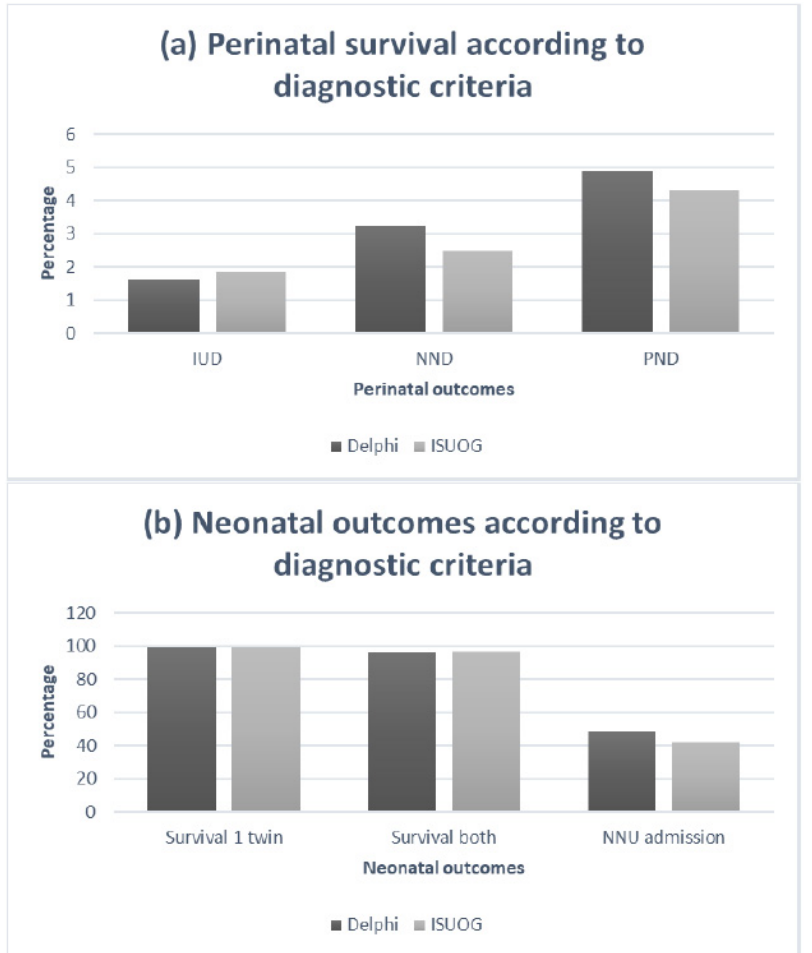
Figure 2. Perinatal and neonatal outcomes of sFGR DCDA twins according to Delphi and ISUOG diagnostic criteria: ( a ) Bar chart demonstrating the incidence of IUD (intrauterine demise), NND (neonatal death), and PND (perinatal death) in the Delphi and ISUOG criteria groups; ( b ) Bar chart demonstrating the incidence of neonatal outcomes (survival of one twin, survival of both twins, and neonatal unit (NNU) admissions) according to Delphi and ISUOG criteria groups.